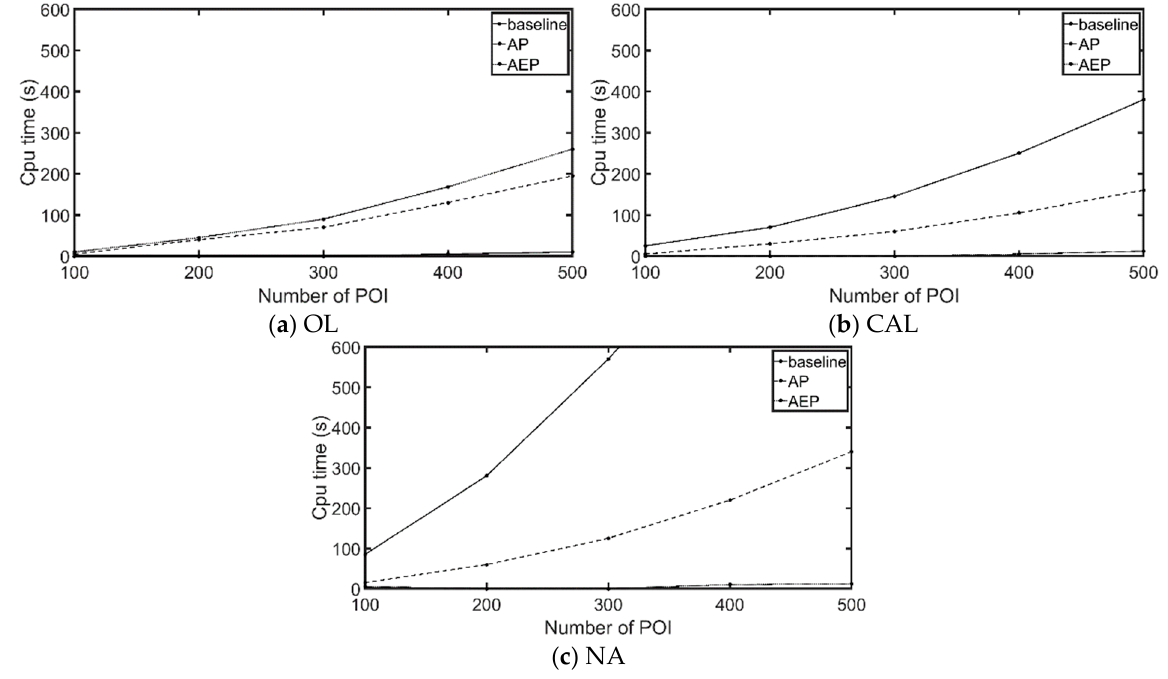
Figure 19. Computation time for queries with different poiNum. ( a ) OL, ( b ) CAL, ( c )